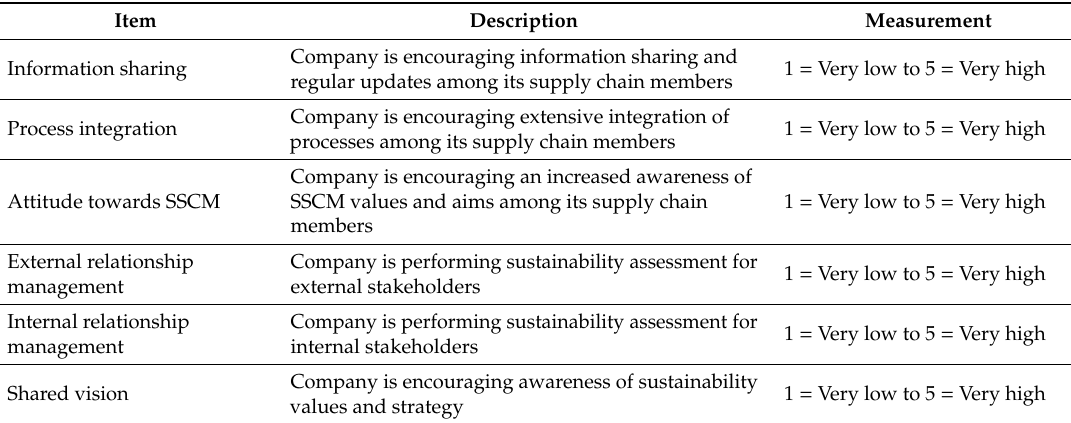
Table 7. Collaboration